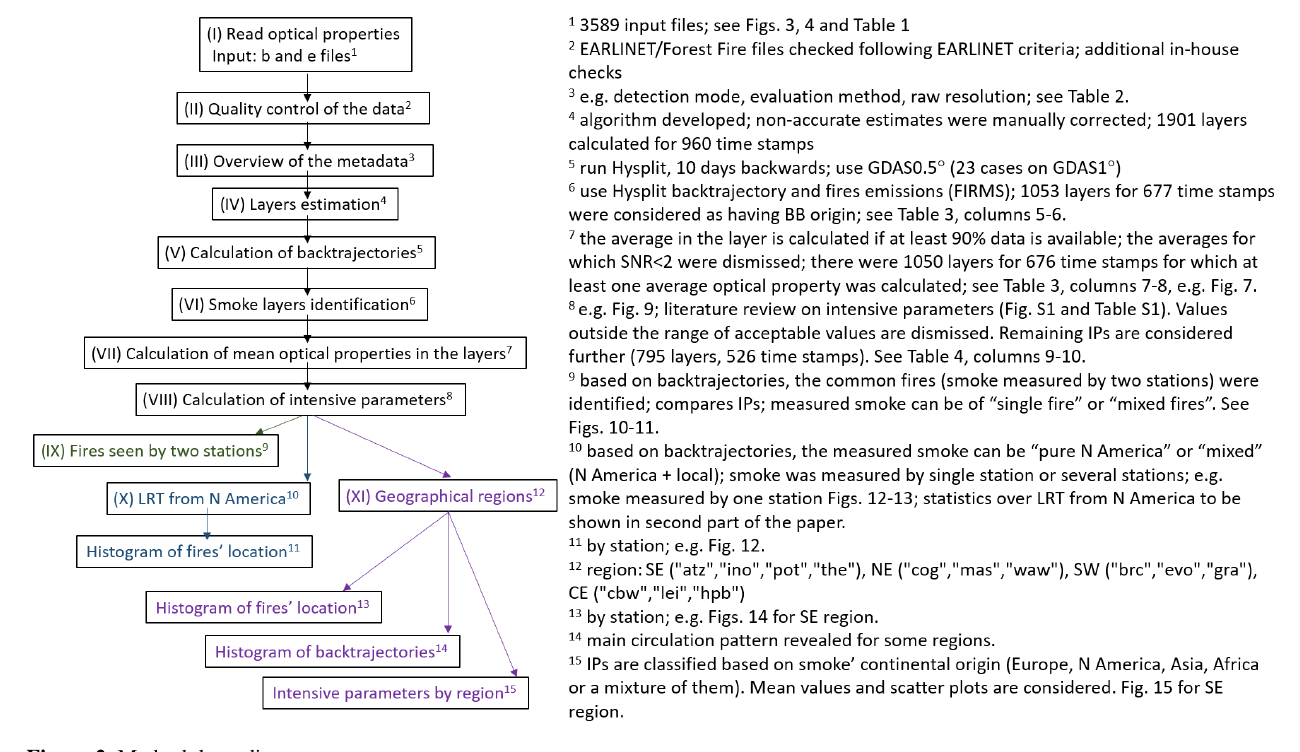
Figure 2. Methodology diagram. Table 1. List of stations and their number of backscatter (b-files) and/or extinction (e-files) at 355, 532, and 1064nm. The number of particle